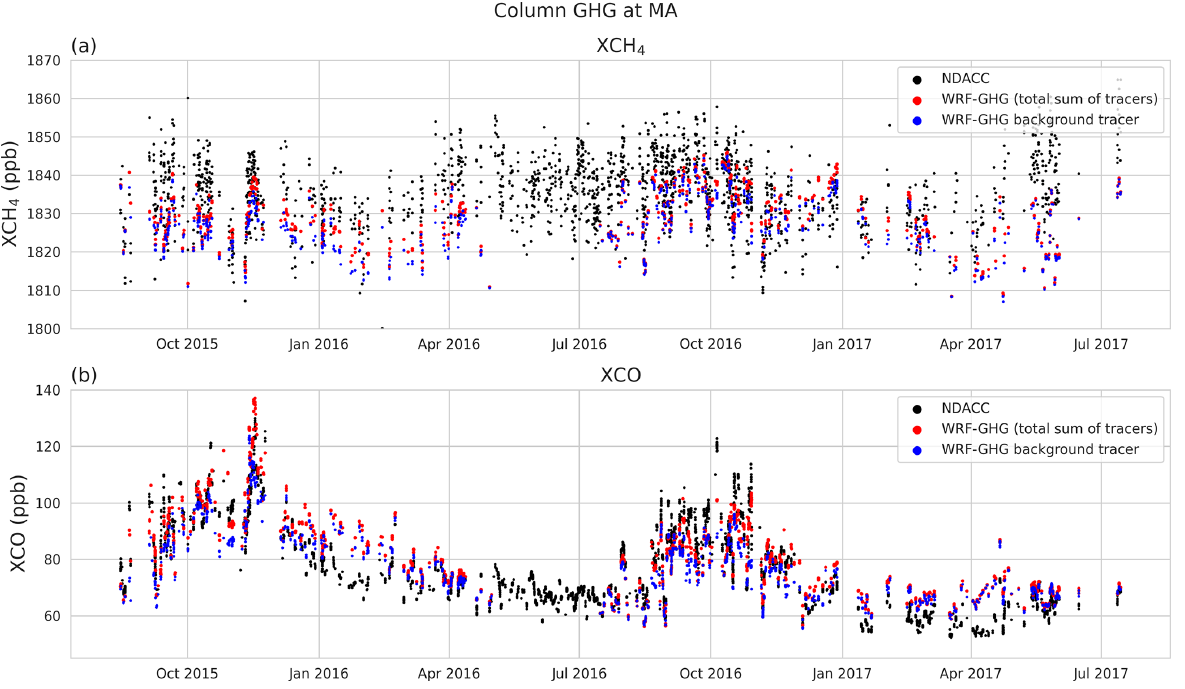
Figure C4. Time series of all observed (black) and modeled (red) column concentrations at MA of (a) CH 4 and (b) CO. The blue dots represent the modeled background tracer. The modeled data are hourly and smoothed. The observed data are scaled to atmospheric column until 50hPa, and all available measurements are